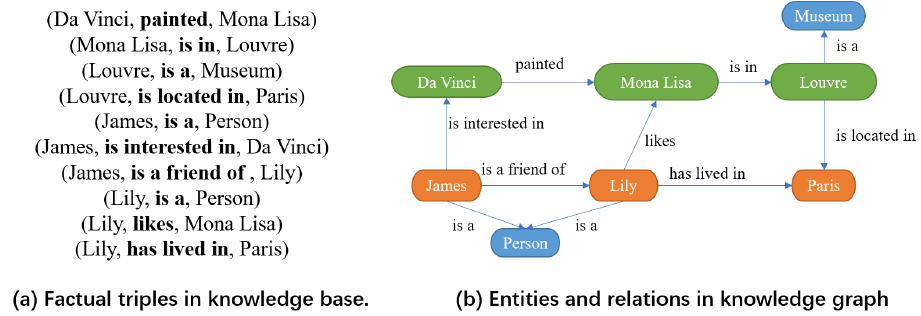
Figure 3. An example of knowledge base and knowledge